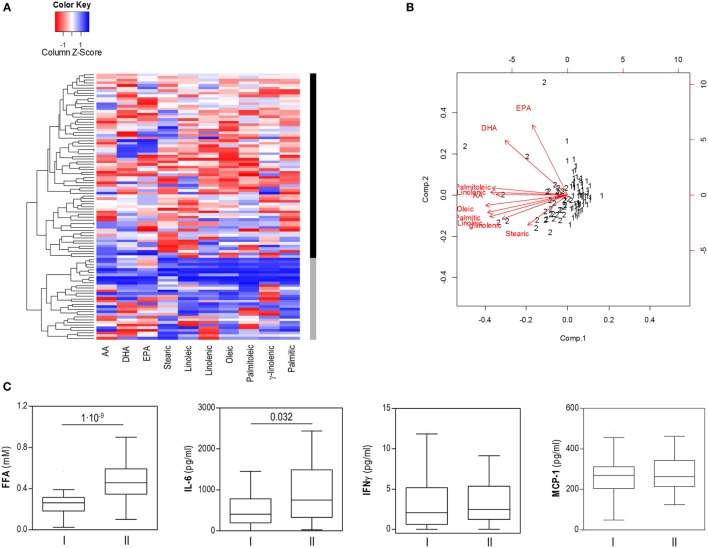
Cluster analysis of free fatty acids (FFA) based on specific FFA serum levels. (A) Heatmap showing dendrogram classification for the clusters based on specific FFA serum levels (columns). Colors in the vertical bar at the right of the heatmap identify clusters I (black) and II (gray). Tiles are colored based on serum FFA concentrations, red and blue indicating low or high levels, respectively. (B) Biplot obtained in the cluster analysis of specific FFA serum levels. Red arrows represent the vectors showing the associations among the original variables entered and the outcome of the cluster analysis. Numbers represent the final cluster assigned to each subject (1: cluster I, 2: cluster II). Whereas saturated and mainly pro-inflammatory FA were closely related, EPA and DHA were not involved in clusters definition. (C) Comparison of serum levels of FFA, IL-6, IFNγ, and MCP-1 between subjects of both clusters. Boxes represent median and interquartile range, whereas whiskers represent minimum and maximum values. Differences were assessed by Mann–Whitney U tests.